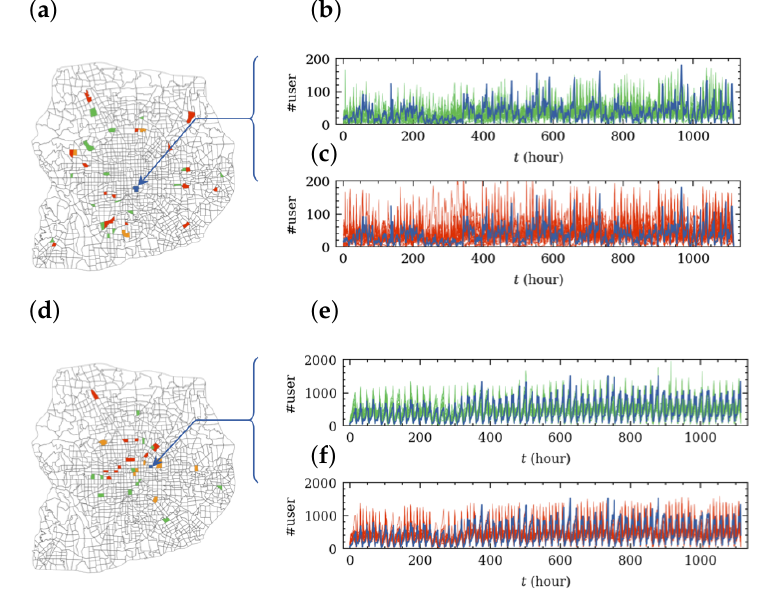
Figure 8. Consensus between the spatial and temporal patterns of TAZs retrieved by the proposed method and the reference method. ( a ) The spatial distributions of the retrieved TAZs similar to Temple of Heaven; ( b ) Temporal patterns of the similar time series retrieved from the reference method; ( c ) Temporal patterns of the similar time series retrieved from the proposed method; ( d ) The spatial distributions of the retrieved TAZs similar to Sanlitun; ( e ) Temporal patterns of the similar time series retrieved from the reference method; ( f ) Temporal patterns of the similar time series retrieved from the proposed